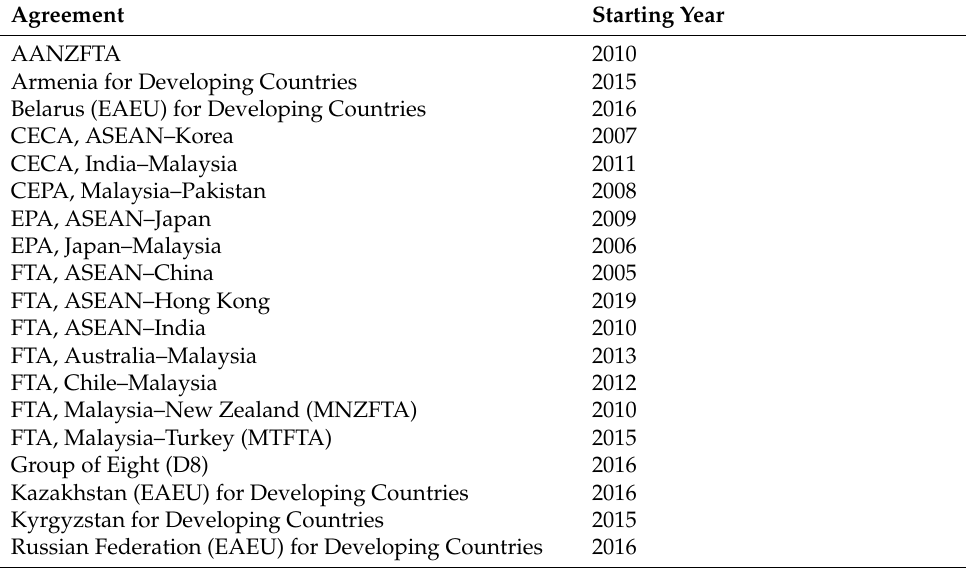
Table A2. Trade Agreements for